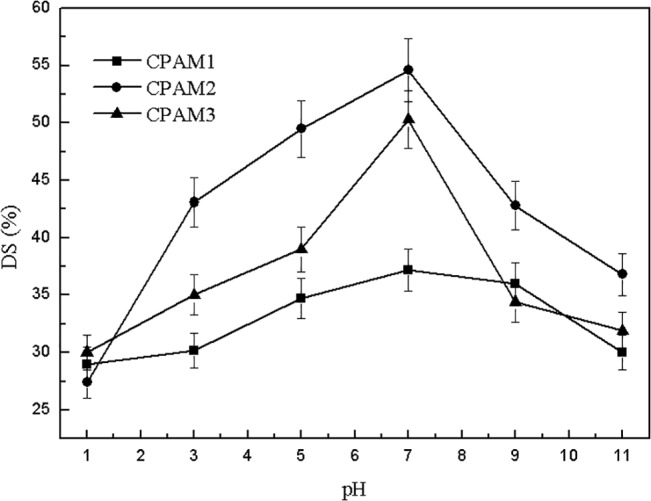
Effect of pH on DS.